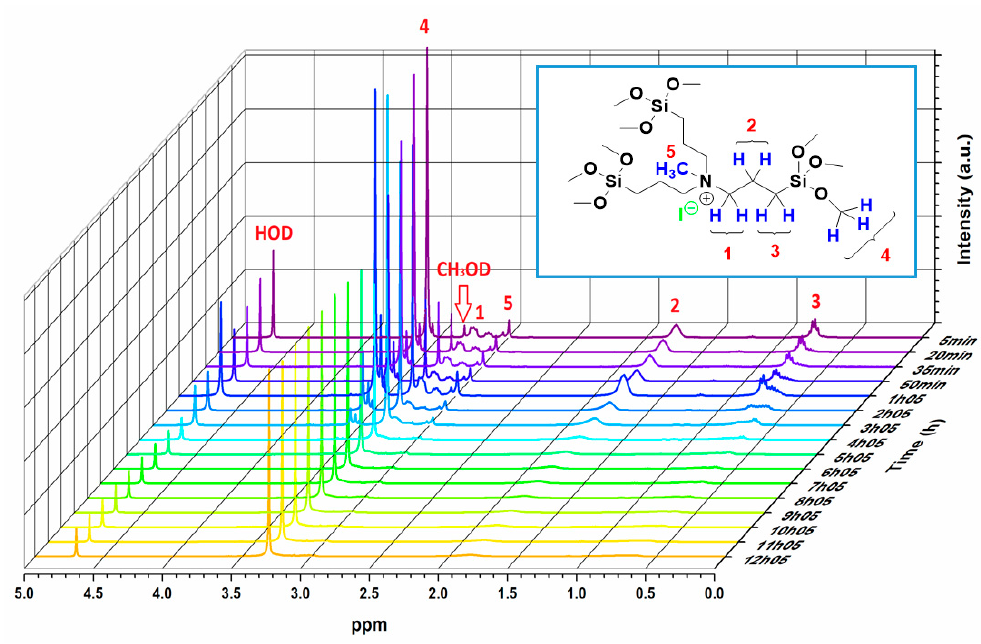
Figure 1. 1 H-NMR kinetic study of the hydrolysis of compound 4 in D 2 O.